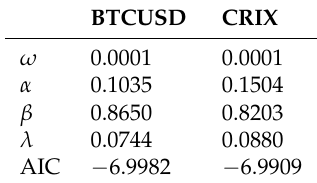
Table 5. GARCH(1,1) calibrated